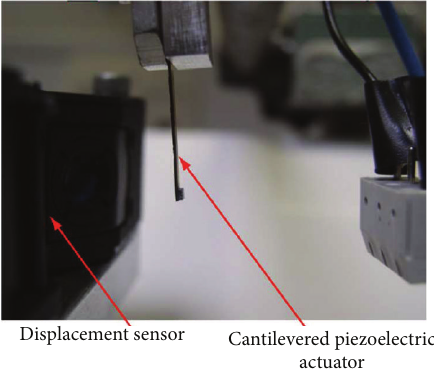
Figure 23: Photography of the piezoelectric actuator [22].